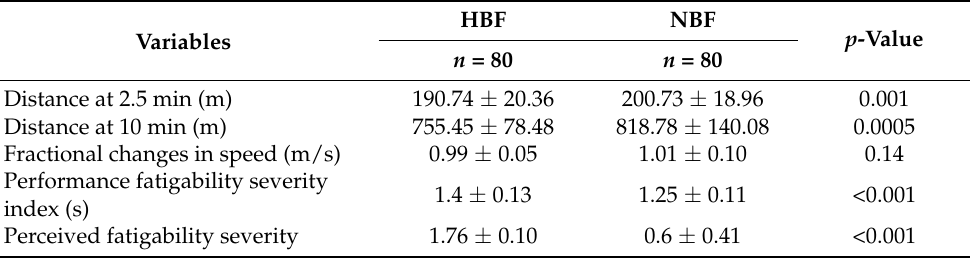
Table 2. Comparison of the performance fatigability during the 10-MWT and the fatigue severity scale between the